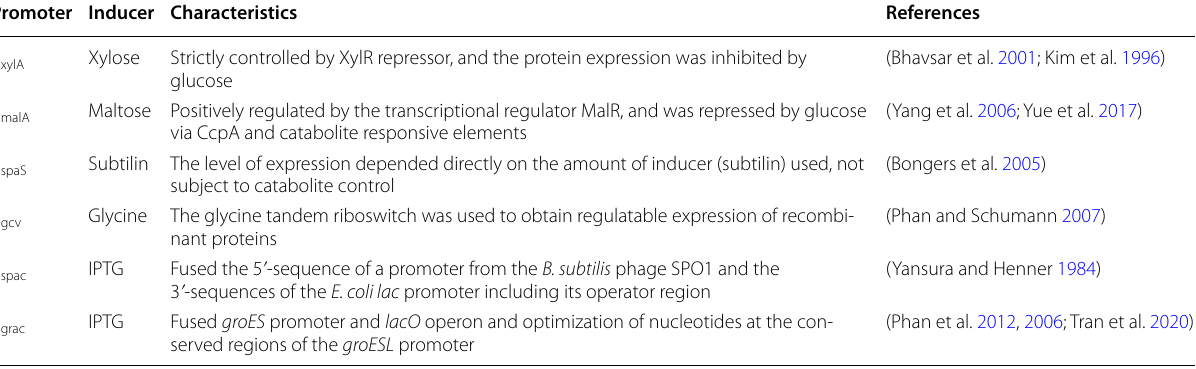
Table 1 The comparison of the protein expression systems of B. subtilis with different promoters Promoter Inducer